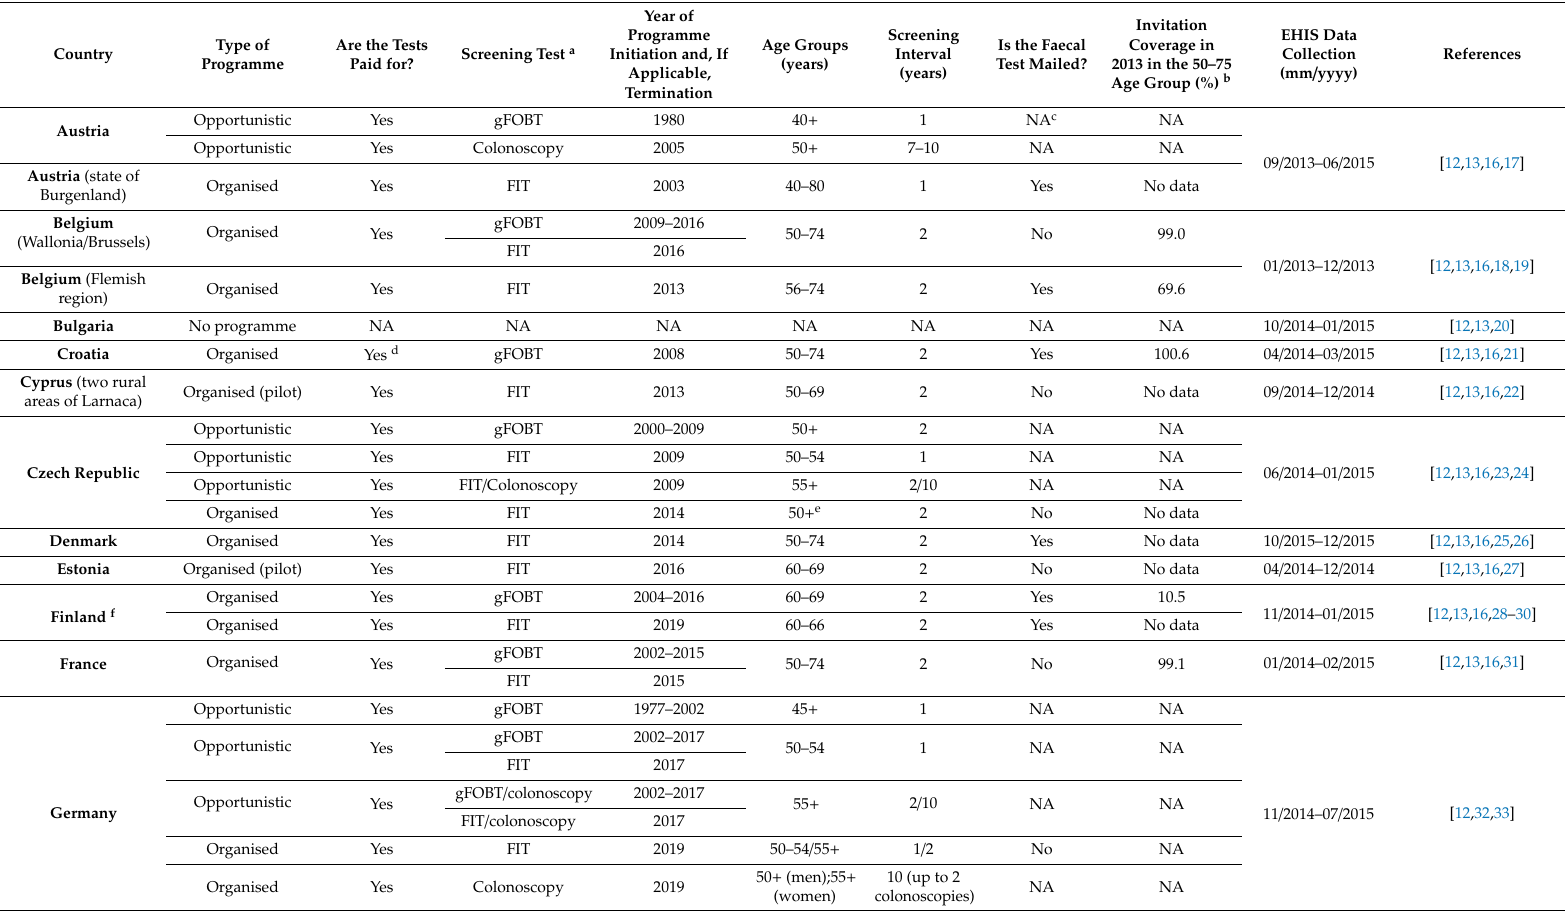
Table 1. Characteristics of colorectal cancer screening programmes in the EU countries, Iceland, Norway and the UK a .